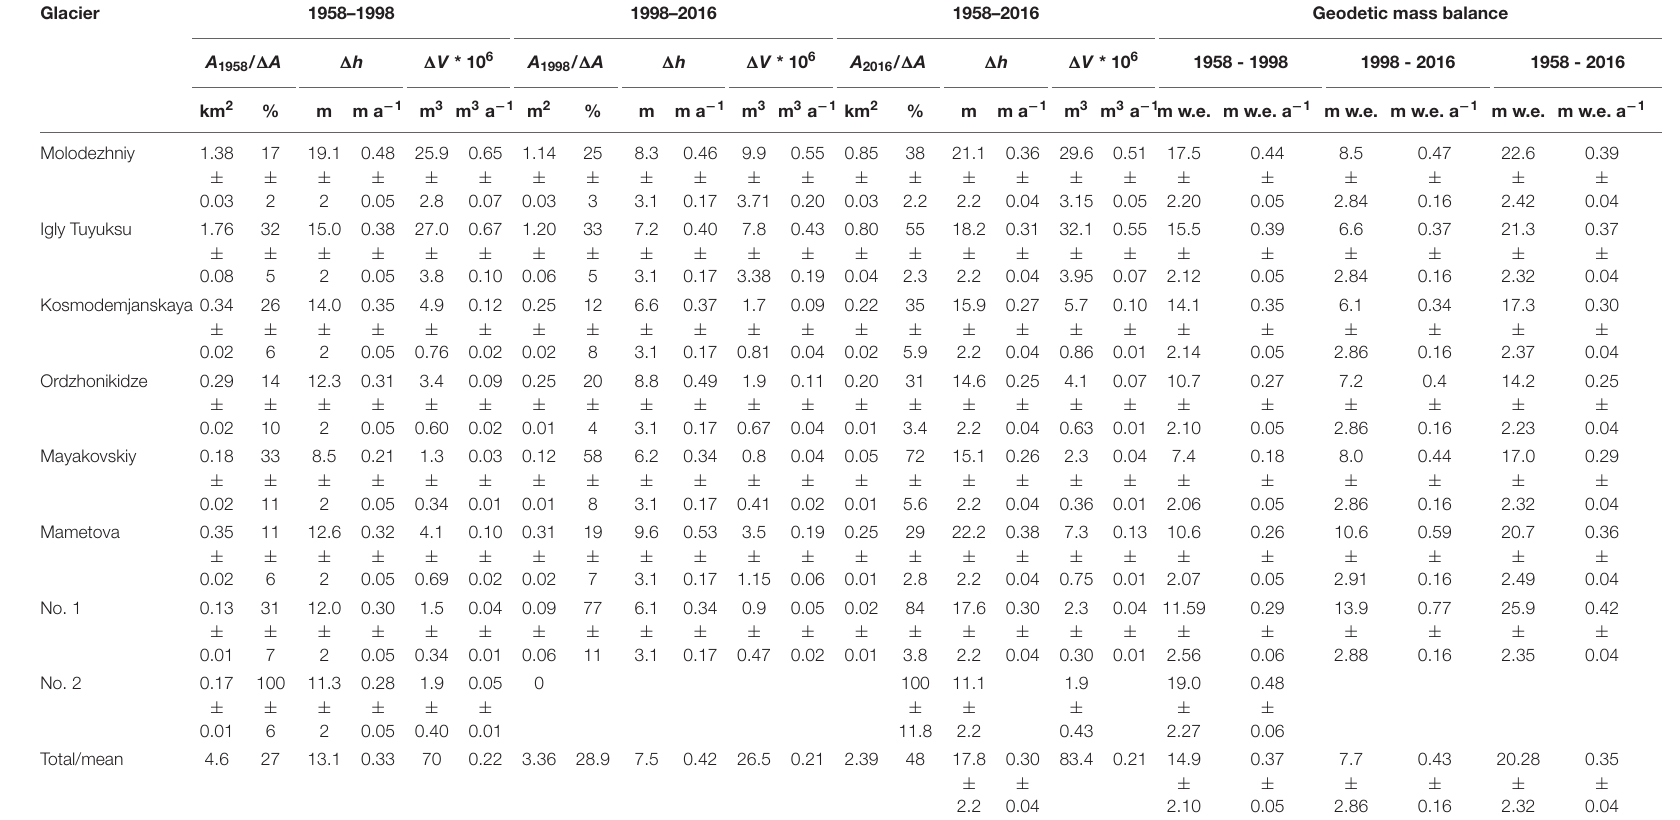
TABLE 4 | Changes in area, surface elevation, volume, and geodetic mass balance of the glaciers of the Tuyuksu group.